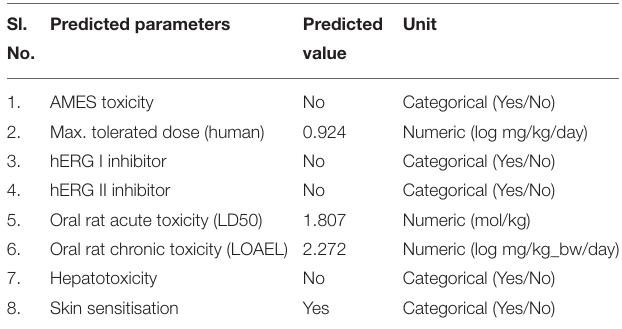
TABLE 4 | In-silico toxicity predicted values of cinnamyl dihydrocinnamate using pkCSM. Sl. Predicted